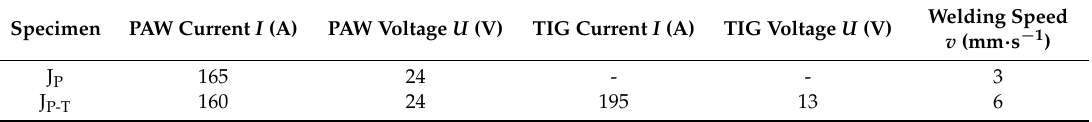
Table 2. Welding parameters of different welding processes.